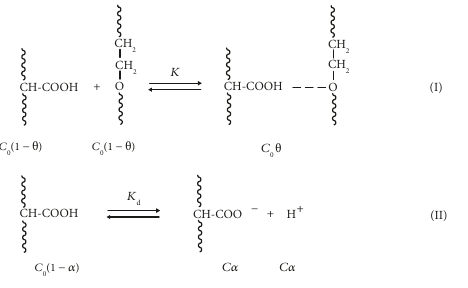
Figure 1: Scheme of the equilibrium reactions involved in the complexation reaction between PAA and PEG.